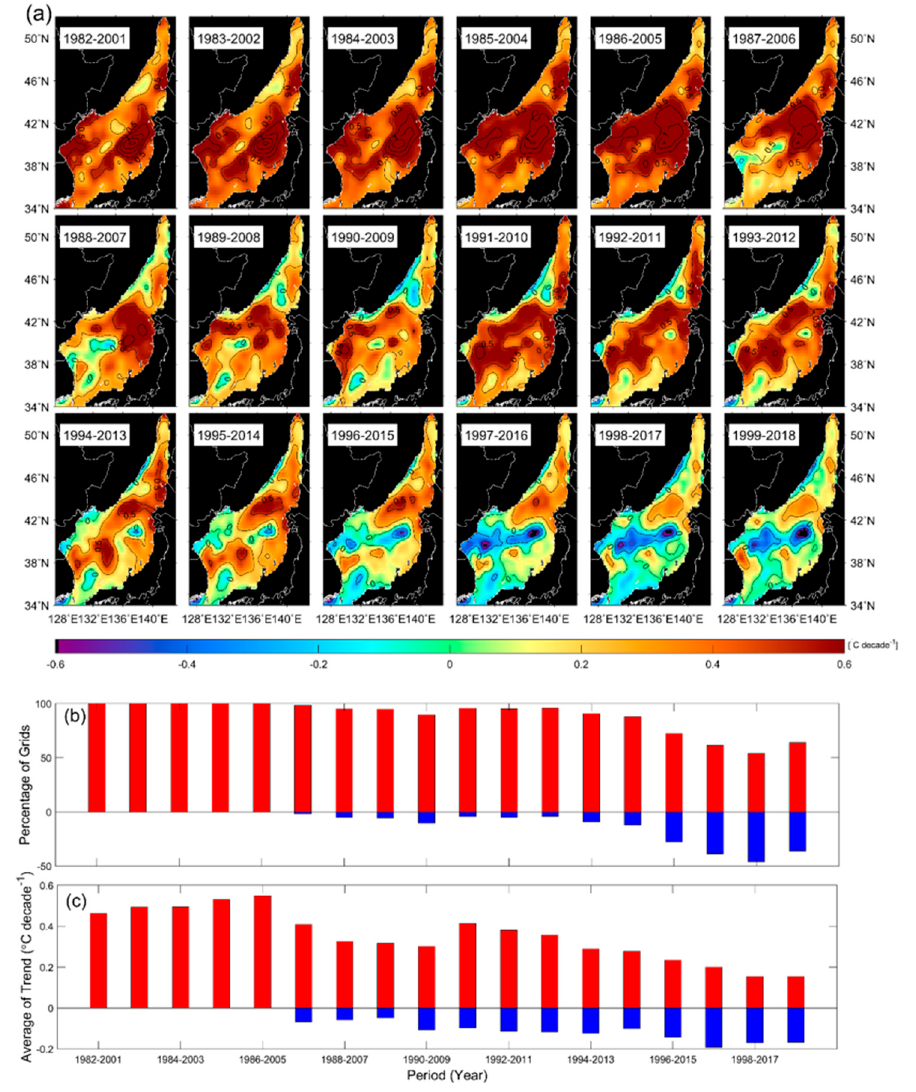
Figure 6. ( a ) Temporal trend for the observation period of 20 years; ( b ) time series of the percentage of the number of the grids; and ( c ) regional averaged trend of ( a ) only for positive (red) and negative (blue) values.